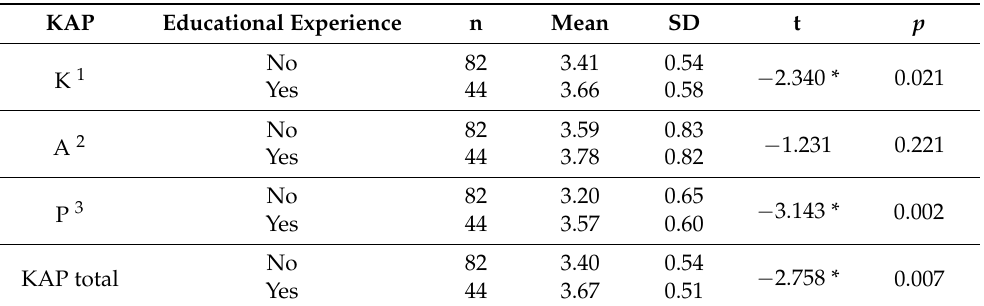
Table 6. Comparison of knowledge, attitude, and practice scores associated with education experience ( n =